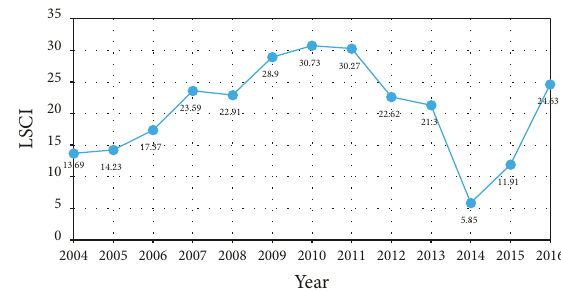
Figure 12: LSCI trend for Iranian ports from 2004 to 2016 (based on UNCTAD